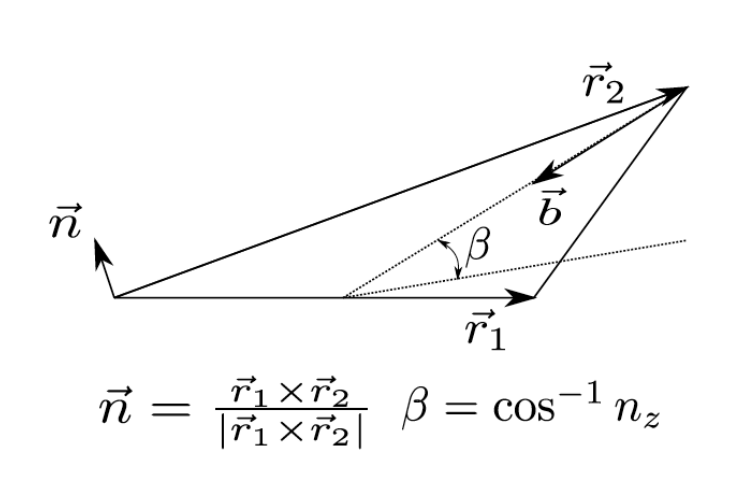
Figure 4. Finding the bed inclination.